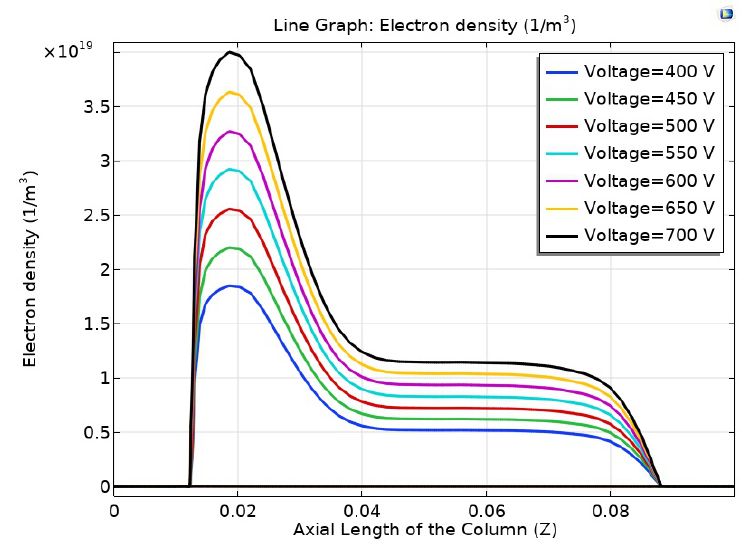
Figure 7. Electron density plots for a voltage sweep of 400 V to 700